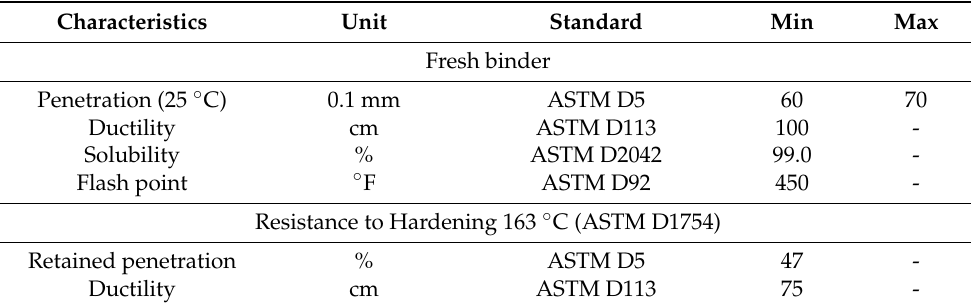
Table 1. Technical specifications of the bitumen